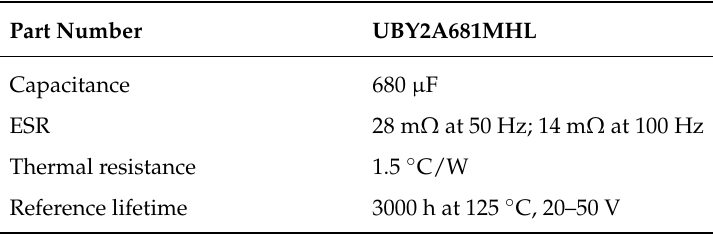
Table 4. Key parameters of the selected capacitor